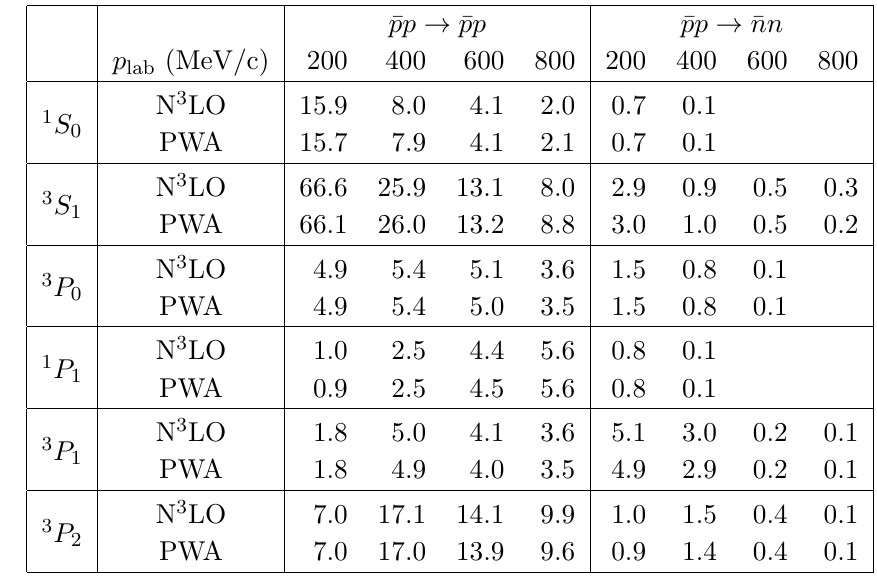
Table 2 . Partial-wave cross sections (in mb ) predicted by the chiral potential at N 3 LO with R = 0 : 9 fm in comparison to results from the (cid:22) NN partial wave analysis [32]. allows us to compare with some existing measurements (for d(cid:27)=d (cid:10), A on ) and it allows us also to document how the quality of the description of (cid:22) NN scattering observables by